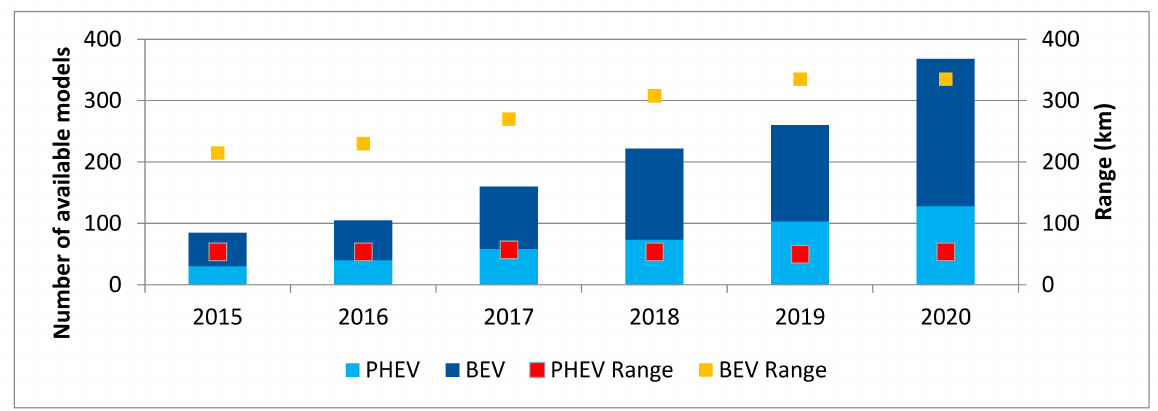
Figure 5. Electric car models available globally and average range, 2015–2020. Source: https://iea.blob.core.windows.net/ assets/ed5f4484-f556-4110-8c5c-4ede8bcba637/GlobalEVOutlook2021.pdf (accessed on 10 October